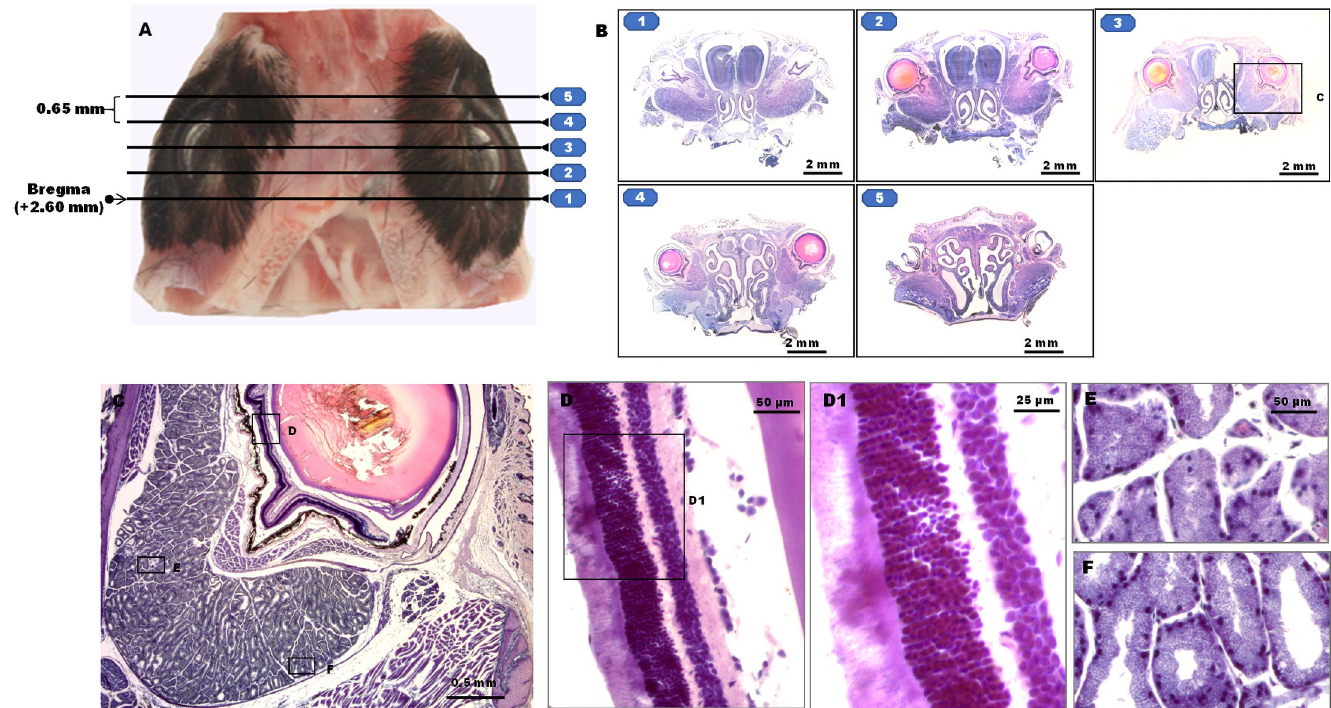
Fig 1. Images of the orbit or eyeball from a 40 weeks‘old BALB/c mouse. The specimen is processed with the protocol of BTA (block tissue staining, tape-aided sectioning, and aqueous mounting). Serial coronary sections of 5 μ m thickness taken at distances of 650 μ m are cut at the positions shown in (A). Images from each cutting position are shown in (B). An image of the right orbit magnified in the middle of the serial (Bregma, +3.90 mm) is shown in (C). Images (D-F) are local magnifications of (C) and D1 is the local magnification of (D).